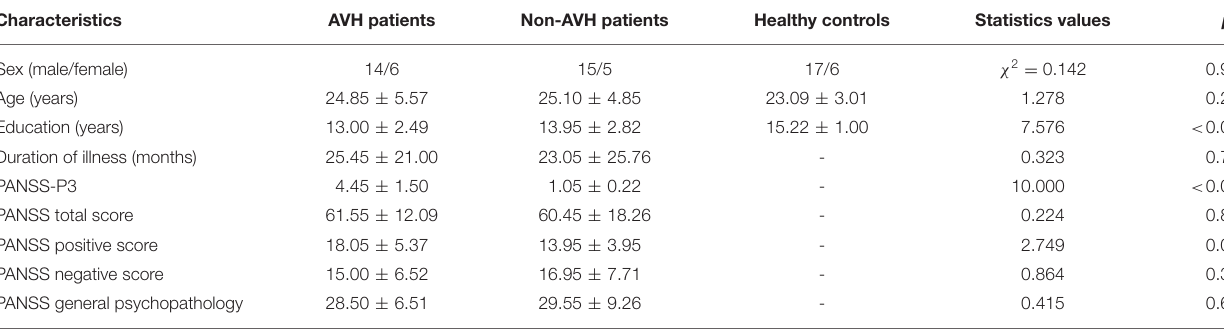
TABLE 1 | Demographic and clinical characteristics of AVH patients ( n = 20), non-AVH patients ( n = 20) and Healthy controls ( n = 23).